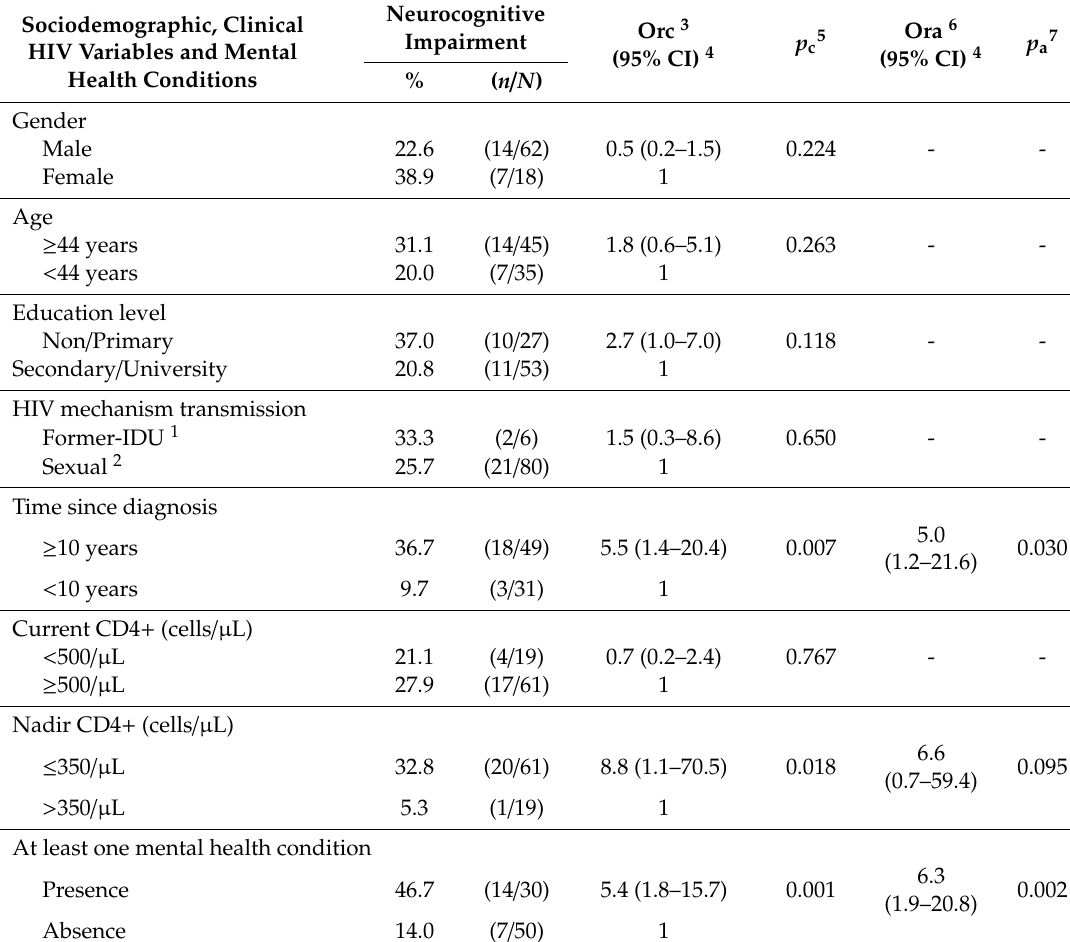
Table 3. Association between sociodemographic, clinical HIV variables and mental health conditions with neurocognitive impairment (NCI) diagnosis ( N =